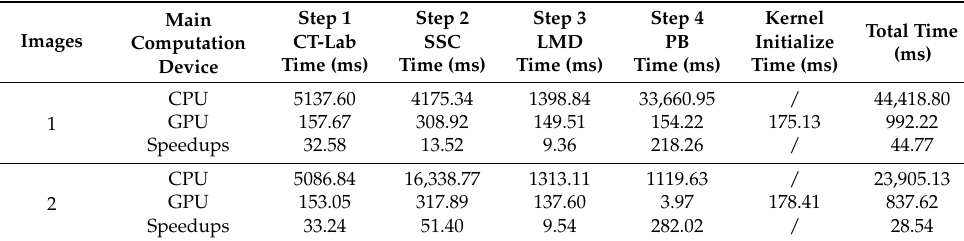
Table 5. Runtime and speedup of the proposed